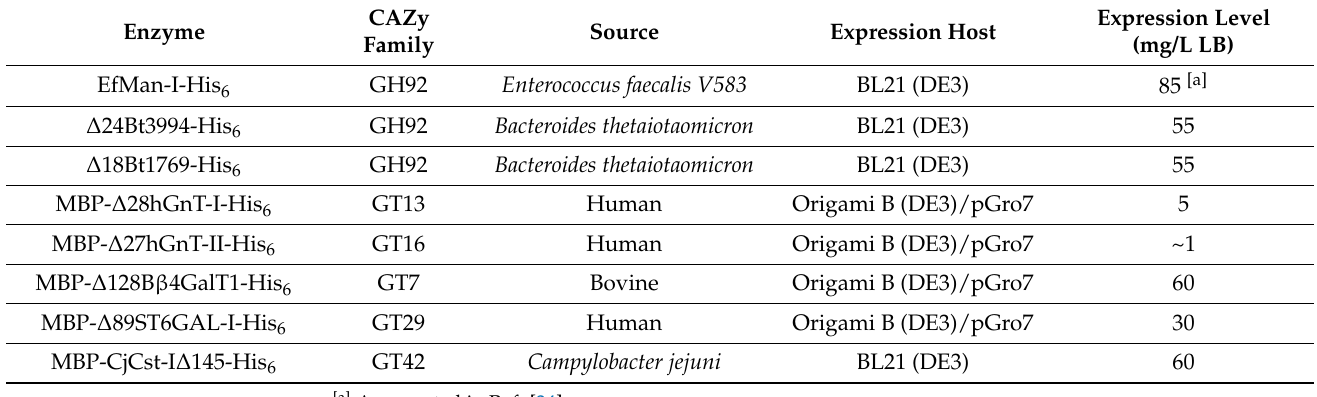
Table 1. Enzymes obtained for glycoprotein in vitro N-glycan processing and their expression levels in E. coli BL21 (DE3) or Origami B (DE3) cells.